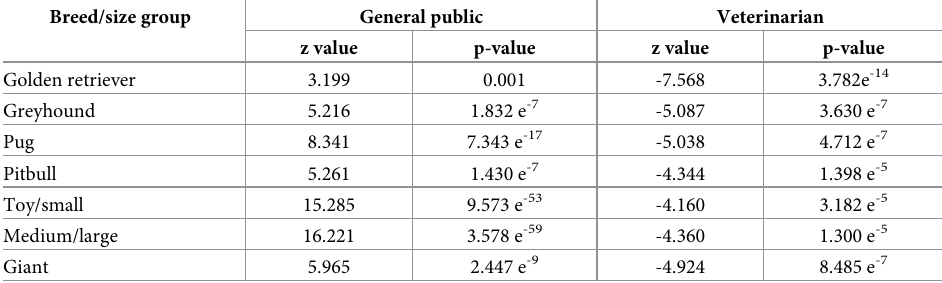
Table 3. Results of cumulative logit models of feelings thermometer ratings and pain sensitivity ratings for breeds and size groups. A Bonferroni-corrected significance level was set at α < 0.0071. Uncorrected p-values are shown; all relationships were